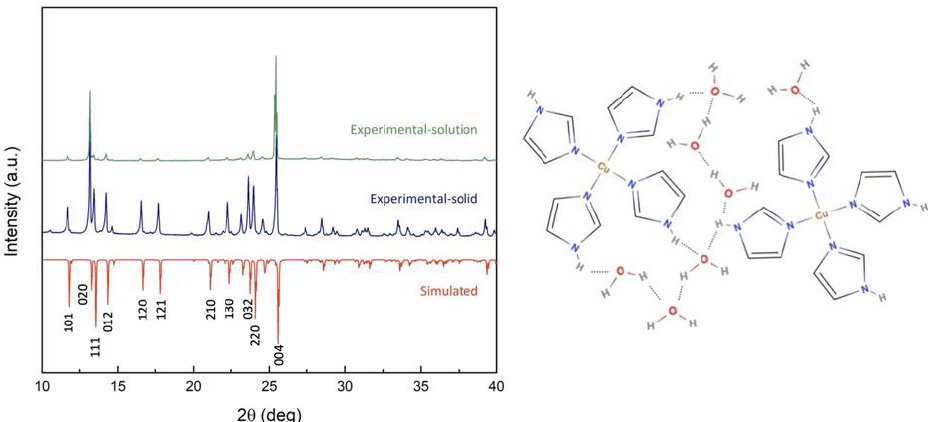
Figure 3. Simulated and experimental XRD patterns of copper(II) coordination complexes ( left ) and hydrogen bond interaction between coordination complexes and water molecules ( right ).